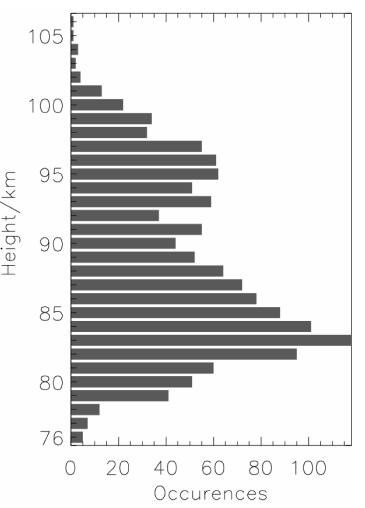
Figure 1. The height distribution of the lidar-observed meteor trails.